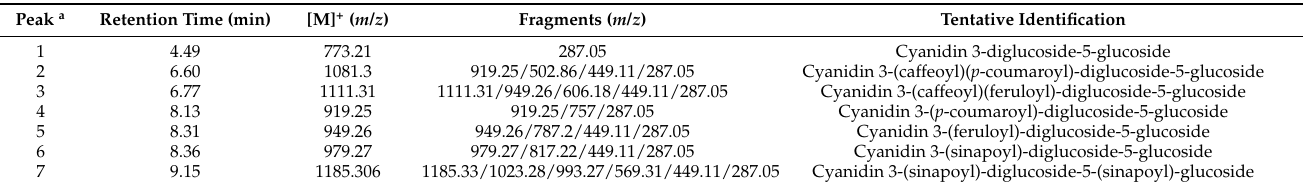
Table 2. Identification of red cabbage juice anthocyanins by UPLC-MS analysis.